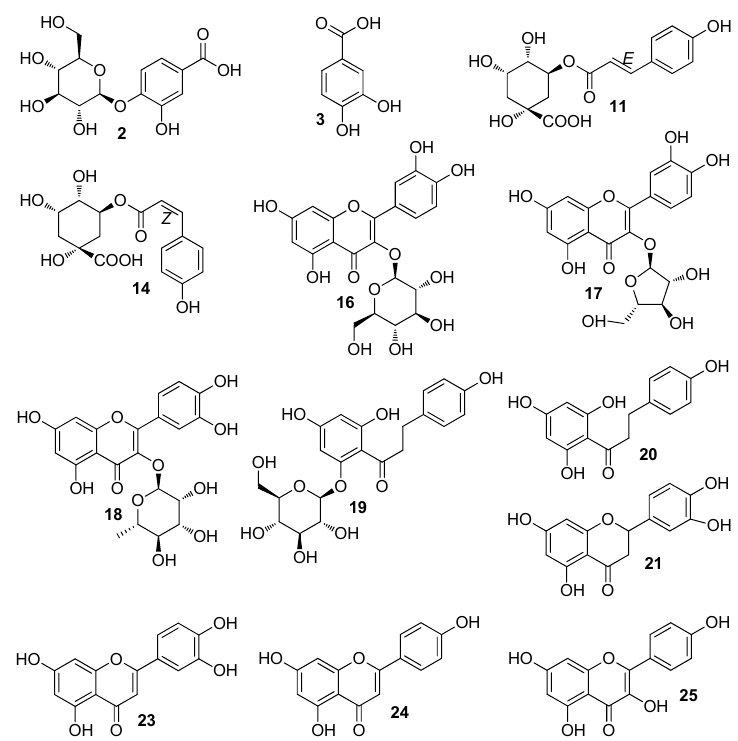
Figure 2. Chemical structures of the phenolic compounds identified for the first time in Hancornia speciosa leaf extract .